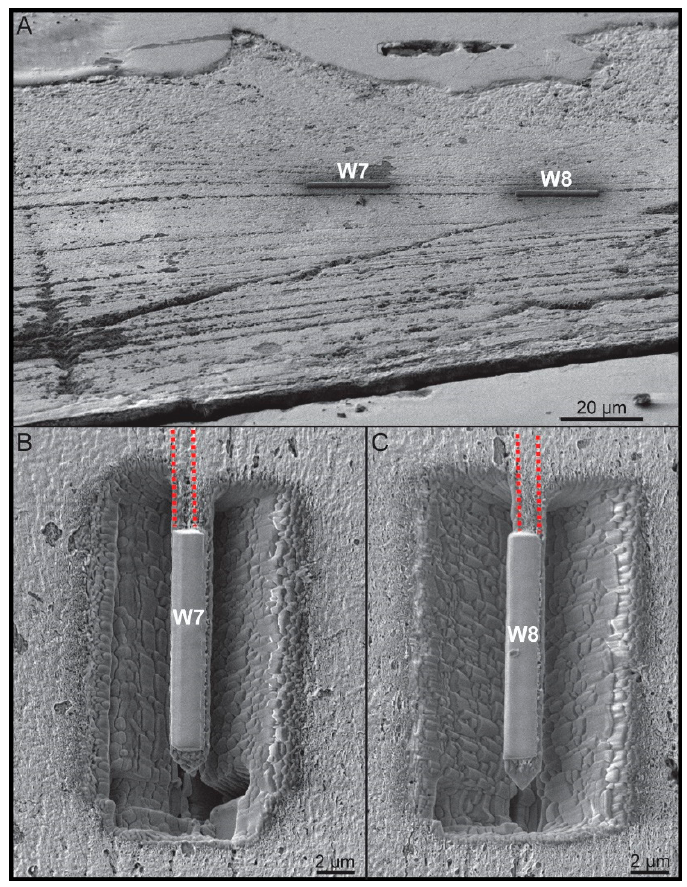
Figure 2. Targeted areas for APT analyses. ( A ) Shell region image showing the location of the platinum (Pt) deposits for focused ion beam (FIB) milling of two wedges (wedge 7 (W7) and wedge 8 (W8)) on the coupled growth lines corresponding to one stria. ( B ) Detailed image of W7 on top of the substrial line (red dashed lines). ( C ) Detailed image of W8 on top of the substrial line (red dashed lines).